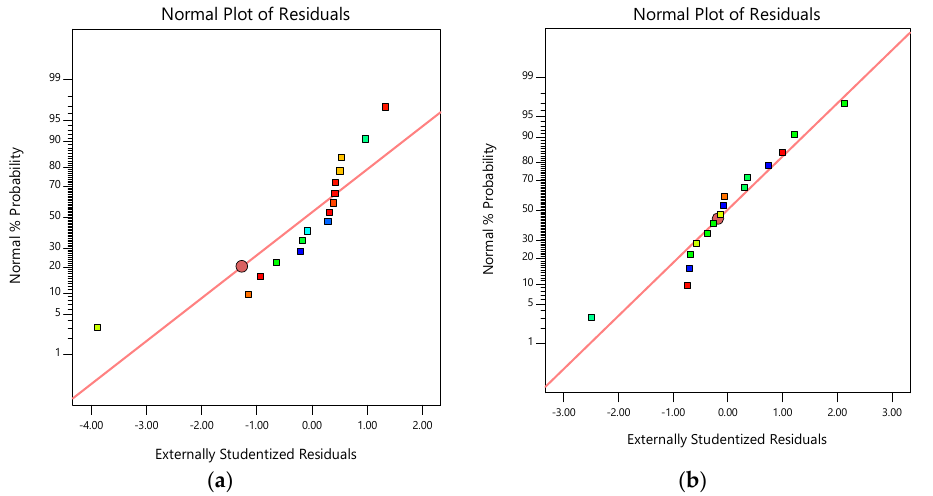
Figure 2. Normal plot of residuals for ( a ) sulphate reduction efficiency and ( b ) sulphate reduction rate. Residuals vs. Predicted